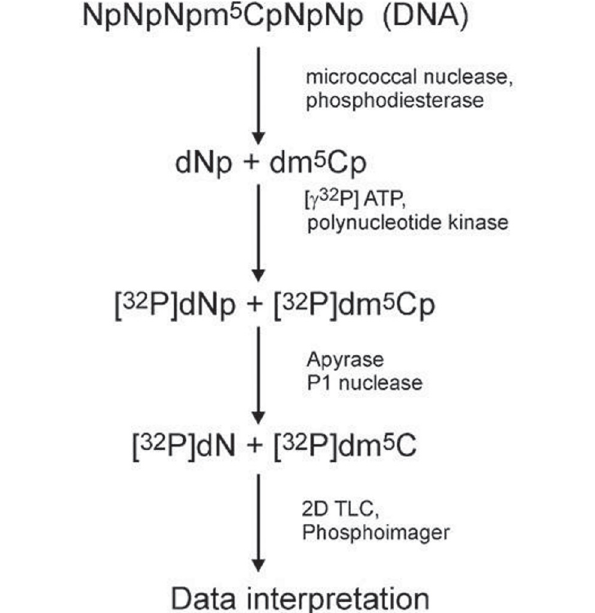
Fig 2. A flow chart of the total DNA methylation (m 5 C) analysis. Isolated DNA is hydrolyzed to 3’- mononucleotides (Np: A/adenosine, G/guanosine, C/cytidine, T/thymidine). The hydrolysate is labelled with [ γ - 32 P] ATP, dephosphorylated (detachment of 3’ phosphate) and separated with two-dimensional TLC. The chromatogram is then evaluated with phosphoimager and the spots’ intensities are measured. Those values are used for the calculation of the R coefficient according to the given equation